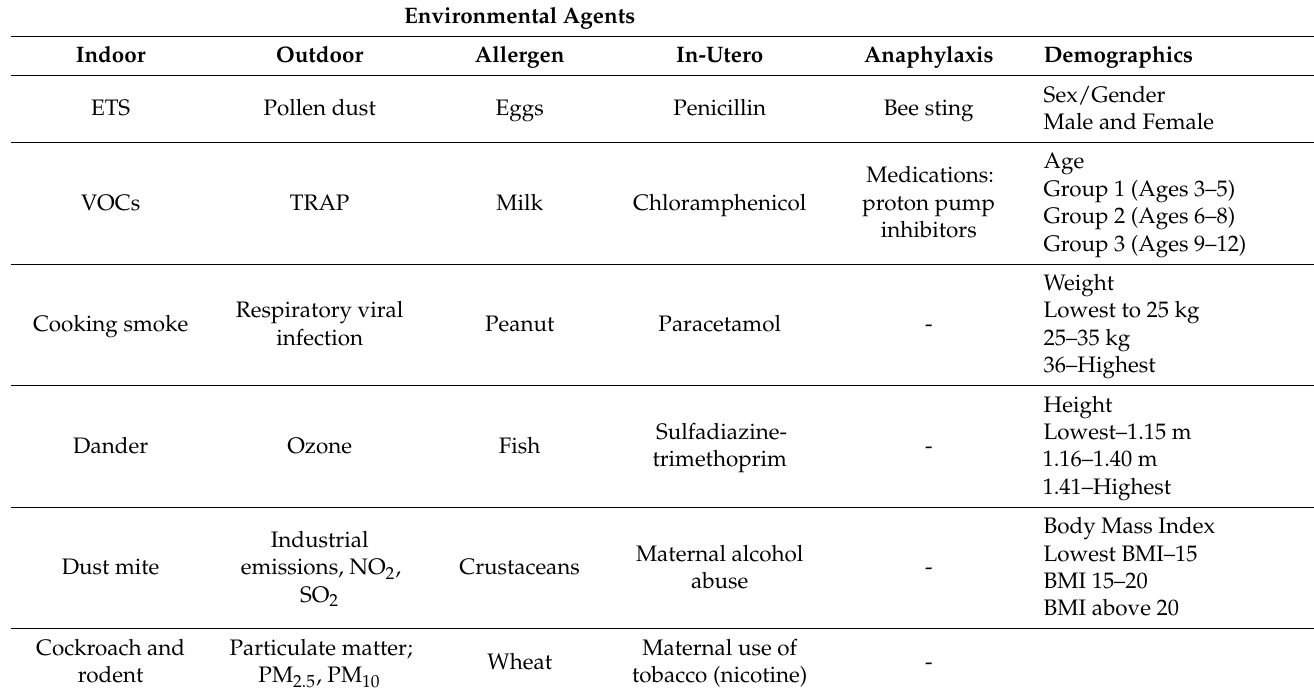
Table 1. Environmental agents and demographic variables assessed in this